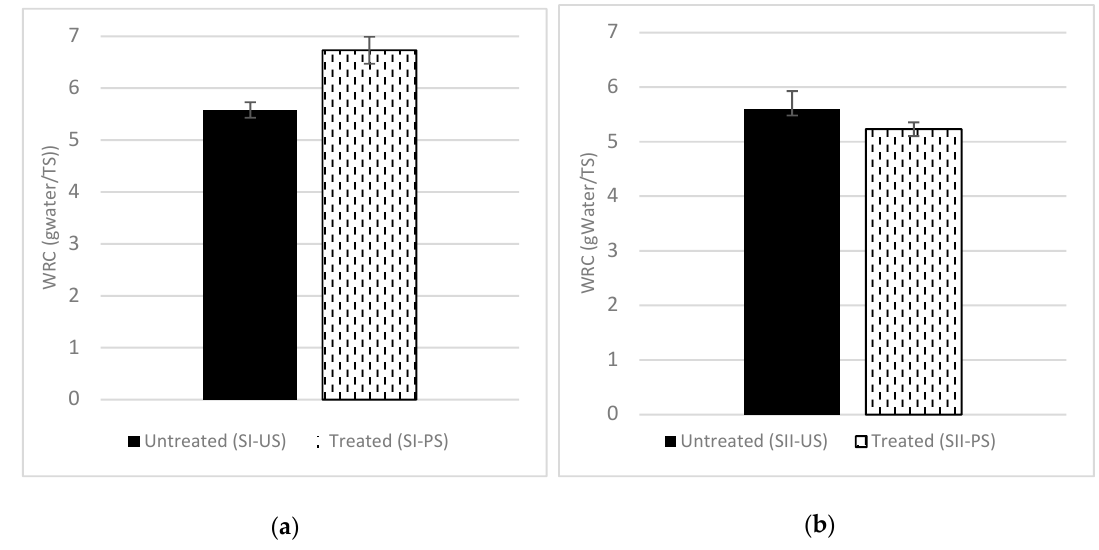
Figure 3. Water retention capacity of untreated and treated samples: ( a ) Site I; ( b ) Site II.